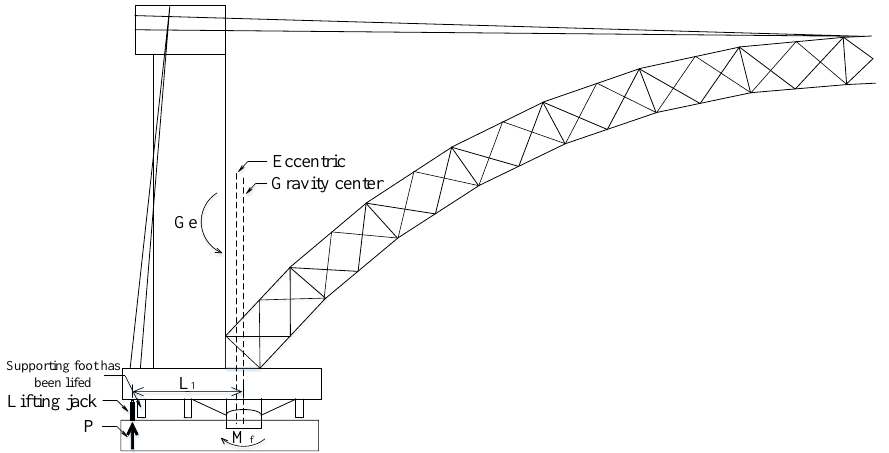
Figure 10. Lifting force on the right side of the rotating system.